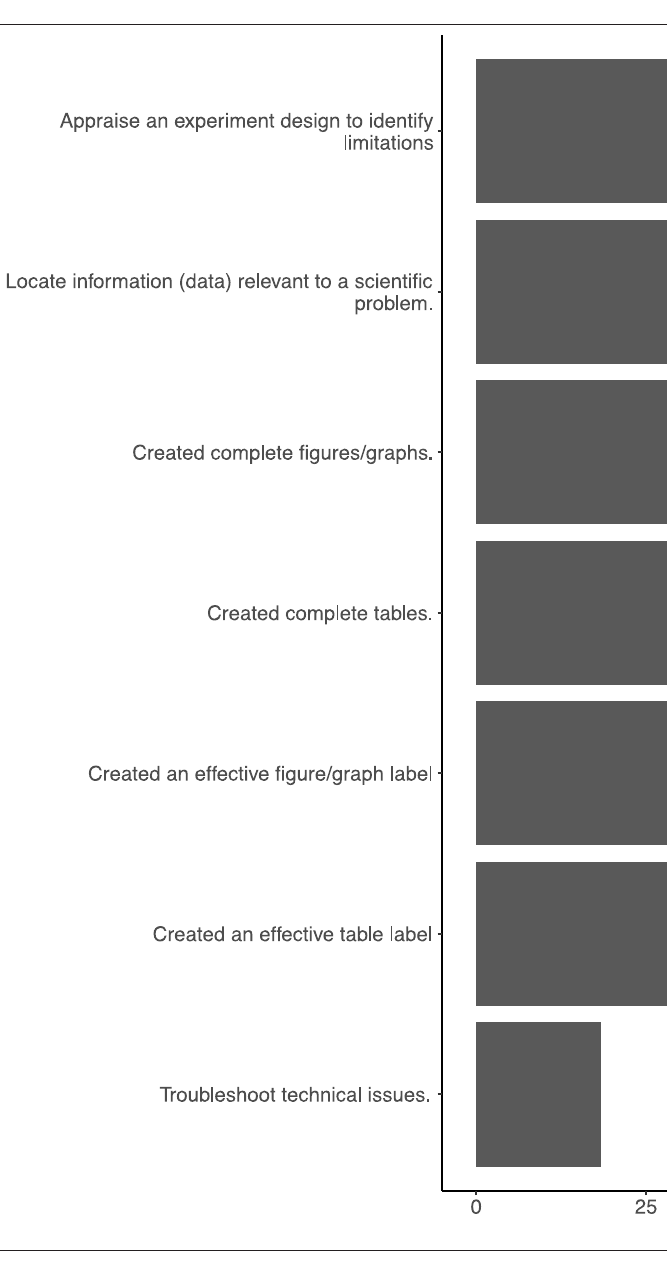
Figure 1 Percentage of students who included different skills for data collection and visualization in their individual